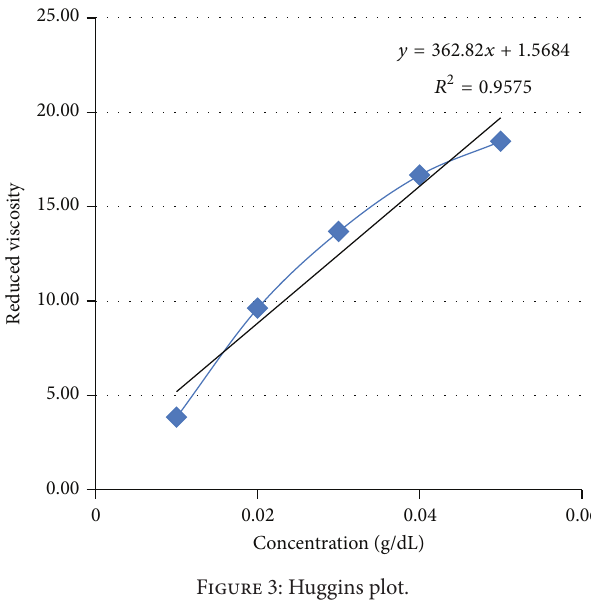
Figure 3: Huggins